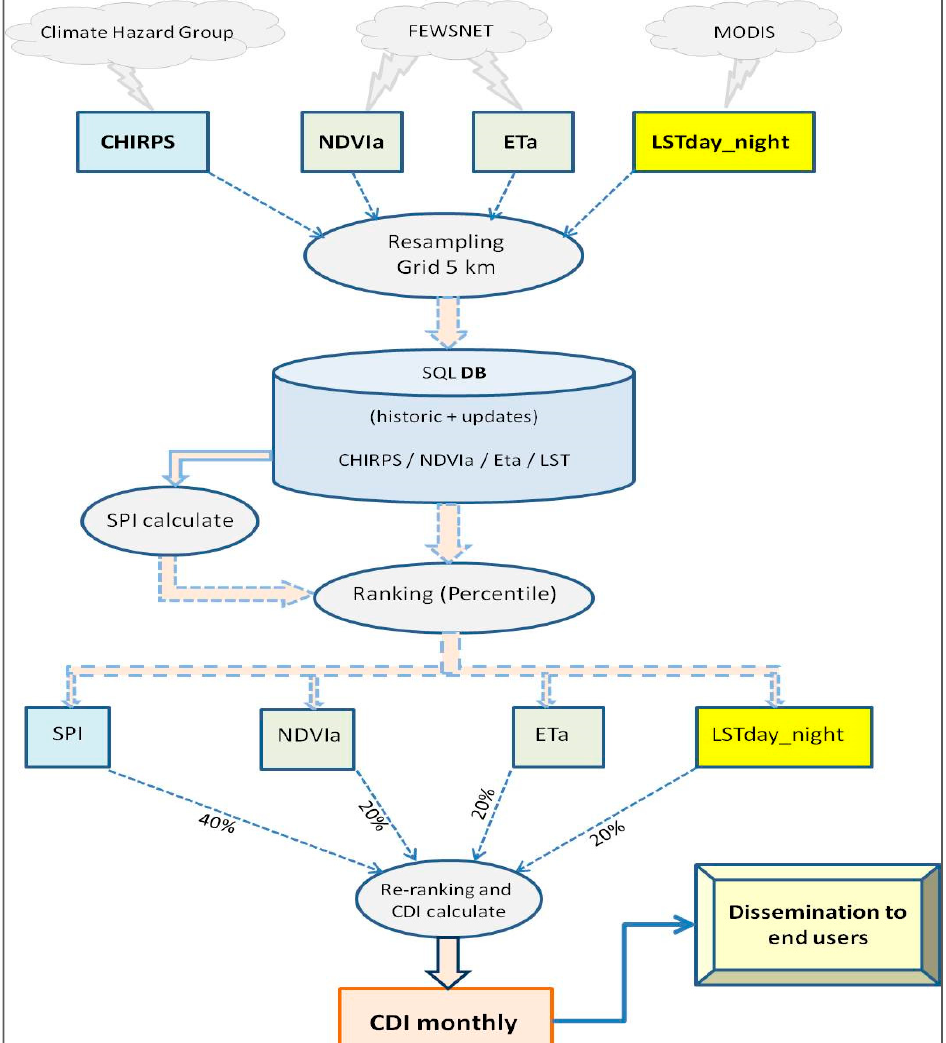
Figure 5. Flowchart of Composite Drought Indicator (CDI) methodology.